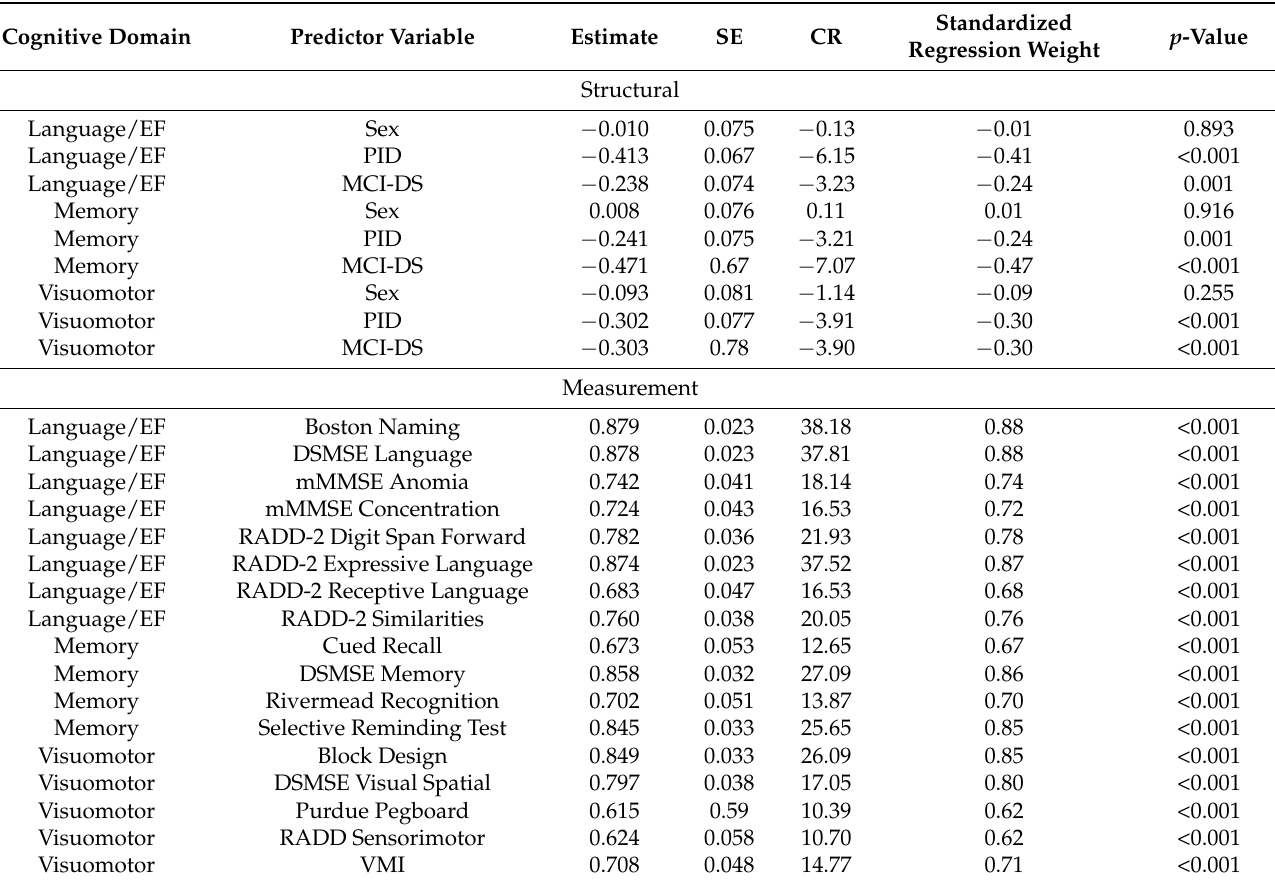
Table 5. The relationship between sex, premorbid ID, MCI-DS, and cognitive